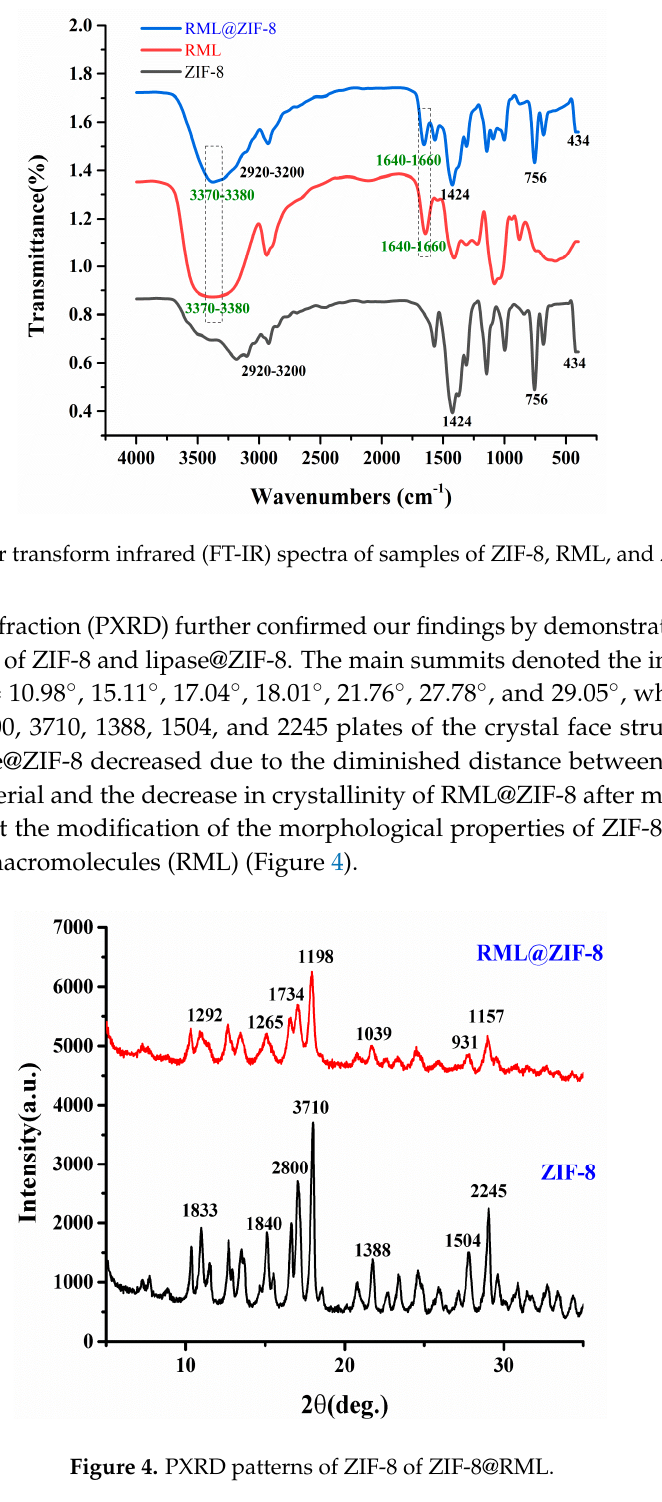
Figure 2. SEM images ( a ) ZIF ‐ 8 and ( b ) ZIF ‐ 8@RML; TEM images of ( c ) ZIF ‐ 8 and ( d ) ZIF ‐ 8@RML;